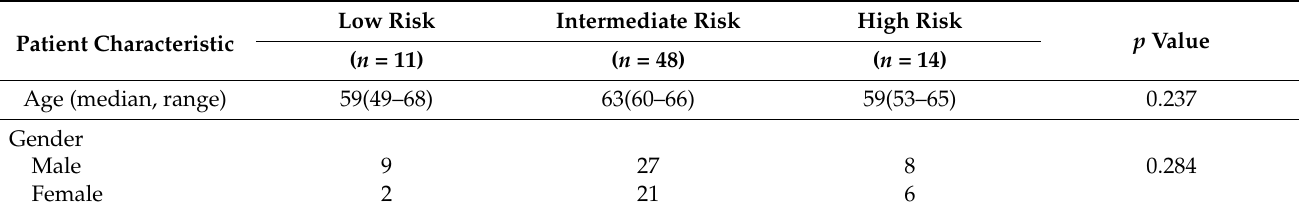
Table A2. Association between prognostic risk groups and the basal clinical